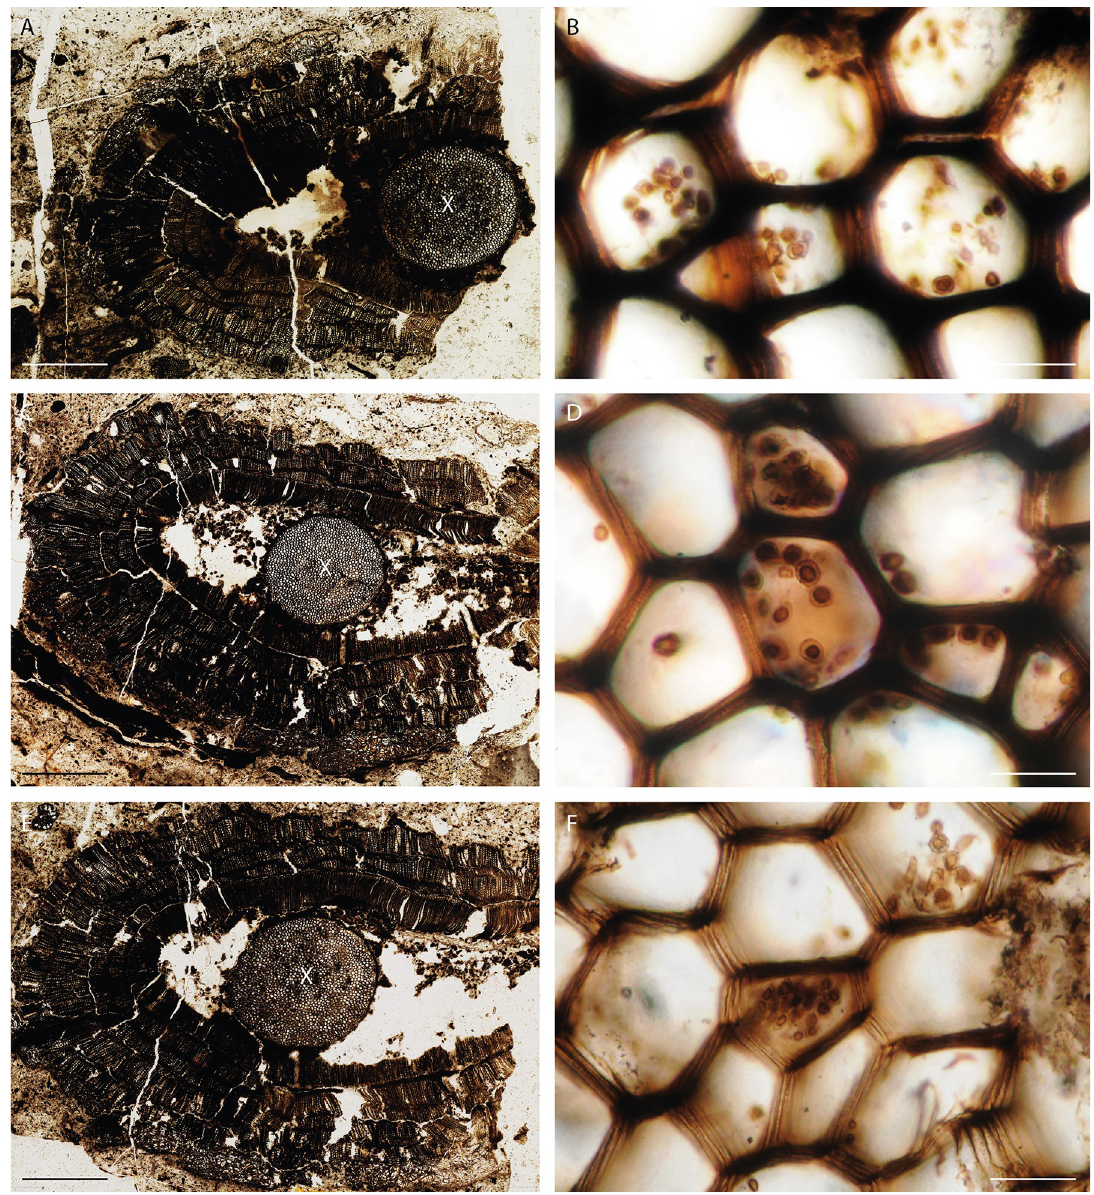
Fig 1. Oochytrium lepidodendri found within the primary xylem of Lepidodendron estonense . The tree branch shows thick layers of radially disposed secondary cortical tissue (A, C, E) around an inner region of the cortex poorly preserved. The primary xylem (X) is the only part of the stele represented; it contains reproductive structures of Oochytrium esnostense (B, D, E). In some areas the xylem cell walls are more degraded (F), this matches with the degradation stage of the inner cortex (E). Scale bars represent 2 mm in (A), 2.3 mm in (C), 1.9 mm in (E), 32 μ m in (B, D), (40 μ m) in (F). (A, B) MNHN.F.48152.0 n˚43 Roche Collection; (C, D) MNHN.F.45876.0 n˚1145 Renault collection; (E, F) MNHN.F.45877.0 n˚1146 Renault collection. (A, C, E photos Gae¨lle